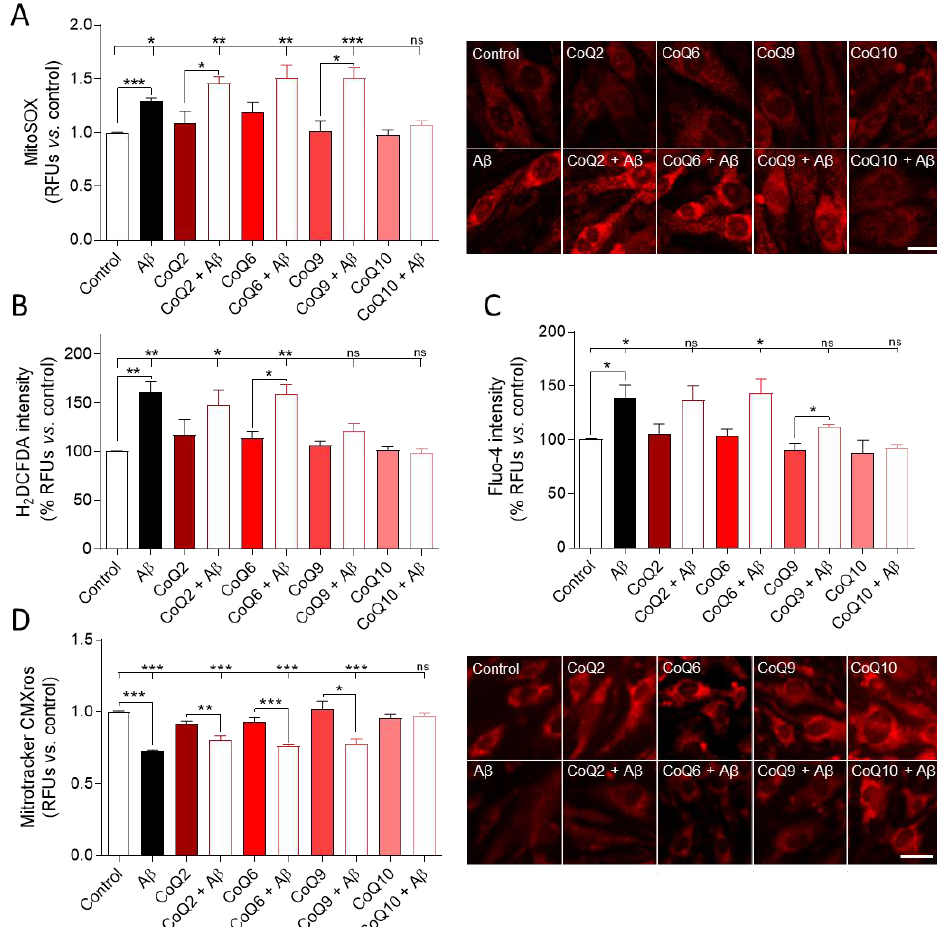
Figure 3. Determination of ROS levels, free cytosolic Ca 2+, and mitochondrial status in cells exposed to A β 25–35 and different CoQs. bEnd.3 cells were pretreated for 24 h with CoQ2, CoQ6, CoQ9, or CoQ10 and then treated with A β 25–35 for 24 h. ( A ) Levels of O 2 − were assessed by a MitoSOX red fluorescent probe. ( B ) H 2 O 2 levels were quantified using a H 2 DCF-DA green fluorescent probe. ( C ) Free cytosolic calcium levels were quantified using a Fluo-4 green fluorescent probe. ( D ) Mitochondrial status was assessed using a Mitotracker CMXRos probe, which is dependent on mitochondrial membrane potential. Results show the RFUs normalized vs. control cells. Data are presented as the means ± SEM. Student’s t -test was used to compare the differences between groups treated with the same ubiquinone and Dunnett’s multiple comparison test to compare each A β 25–35 (plus or minus ubiquinone) treatment with the control. ns: not significant, * p < 0.05, ** p < 0.01, *** p < 0.001 ( n = 3) (scale bar = 20 µM).